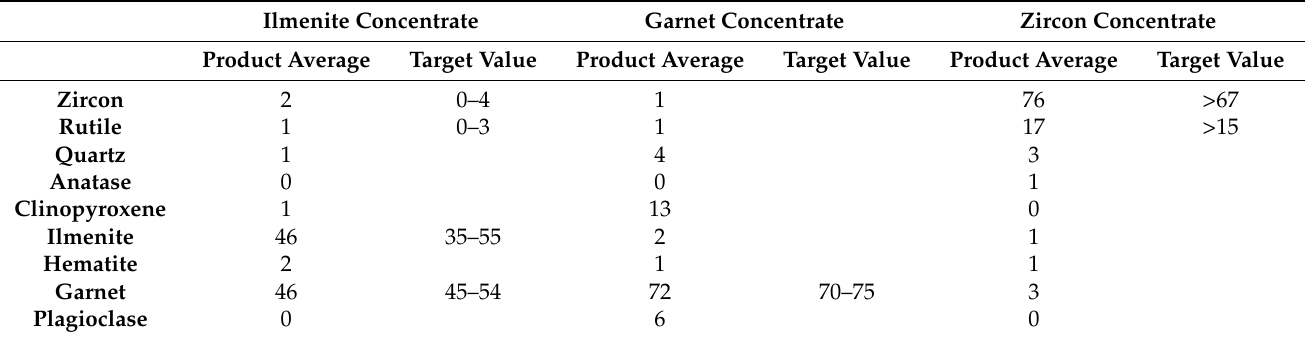
Table 1. Average mineral abundancies (weight%) of 25 weekly composite samples each, and target